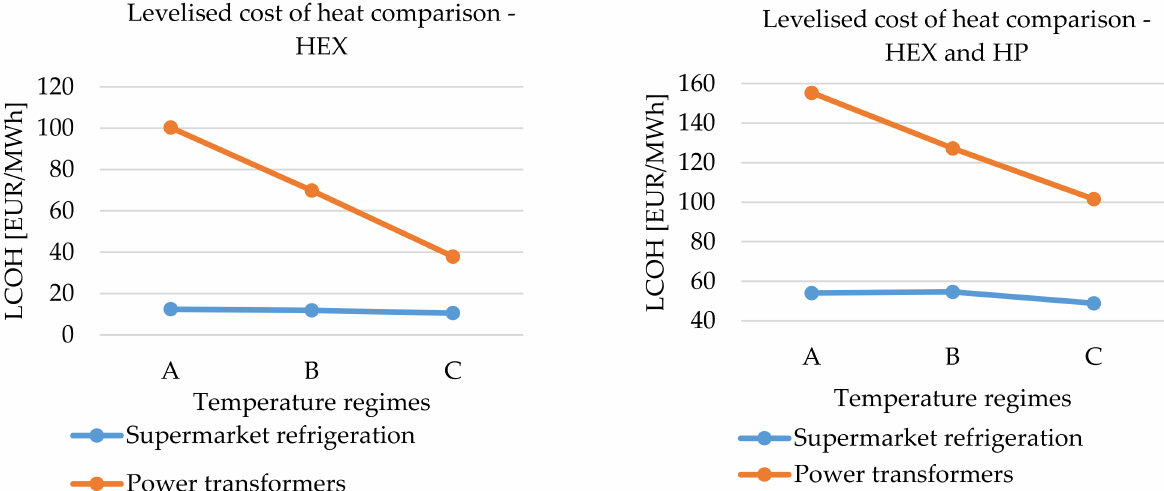
Figure 22. LCOH comparison for different DH network temperature regimes (connection distance 100 m) and utilization technology: ( Left ) Heat exchanger; ( right ) heat exchanger and heat pump.